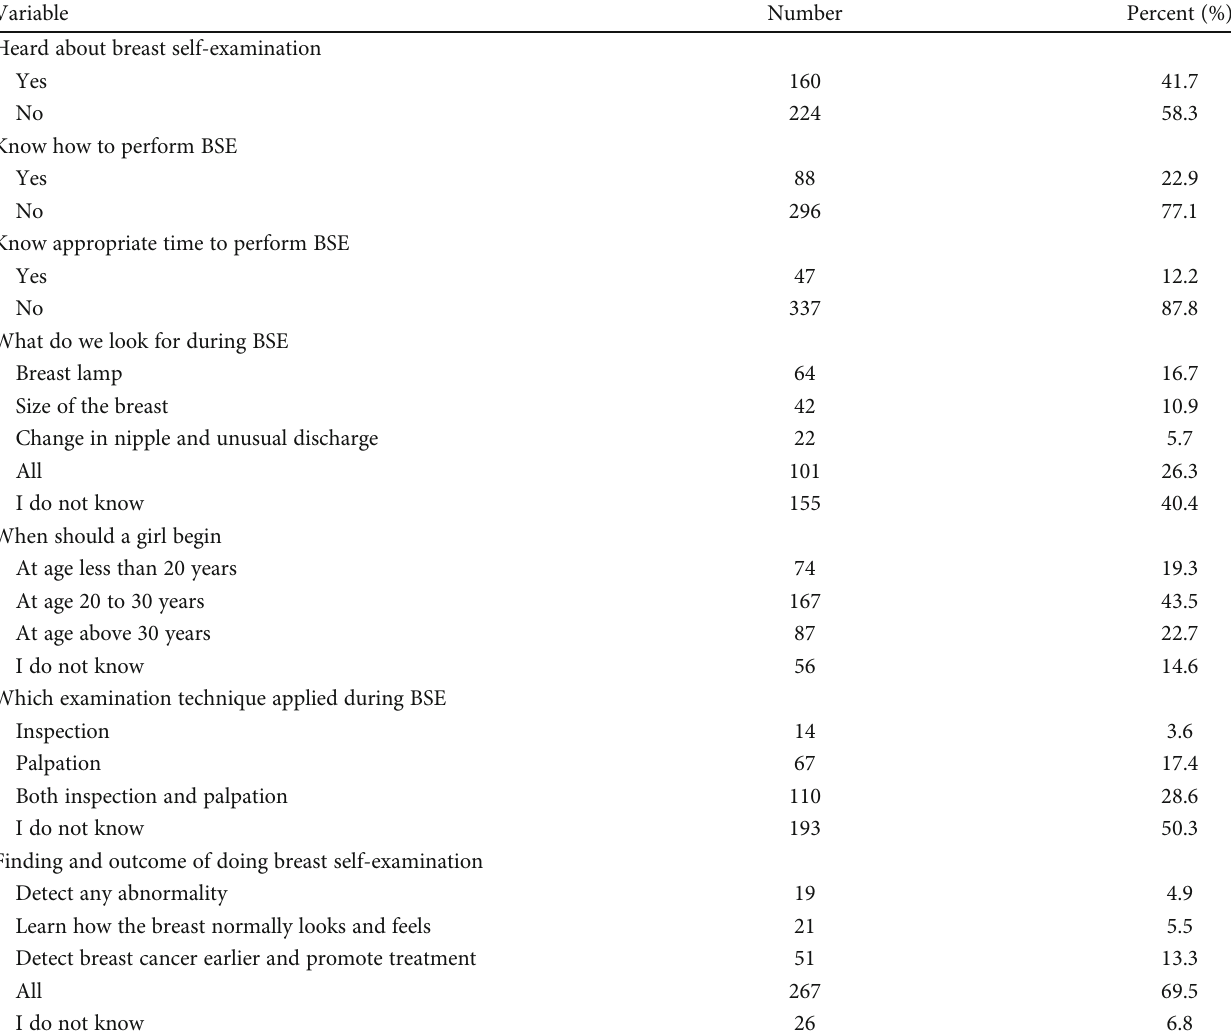
Table 2: Knowledge on breast self-examination among summer social science female students in University of Gondar, Northwest Ethiopia ( n = 384